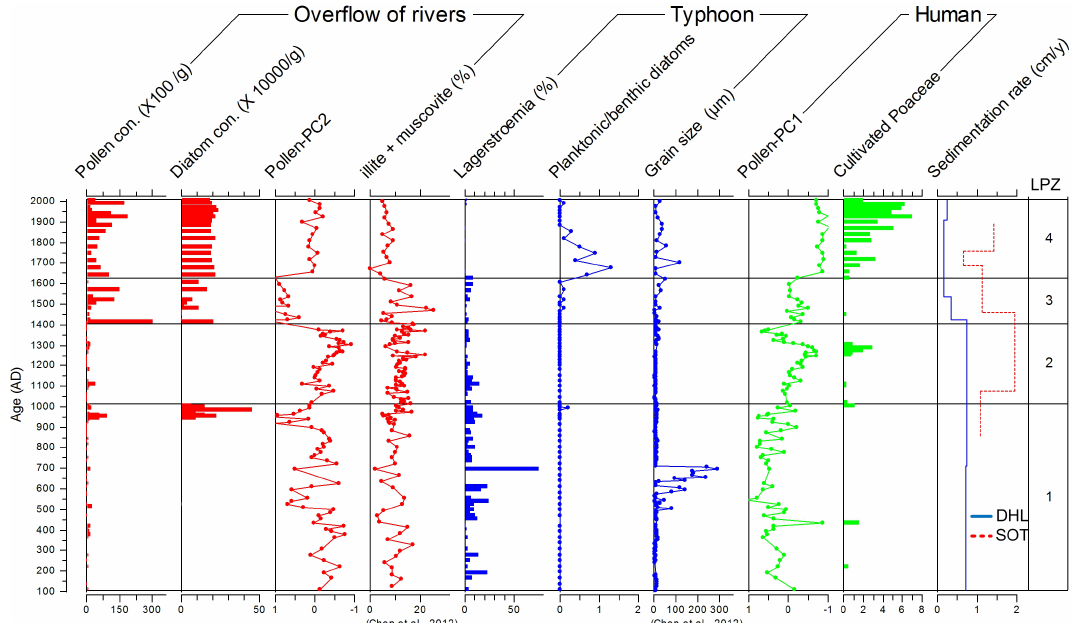
Figure 6. Principal components analysis biplot of pollen compositions in sediments from DHL. The first and second principal components (PC1 and PC2) explain 30% and 20%, respectively, of the variation. The factor loadings of pollen abundance and the factor scores of sediment samples are plotted together in this